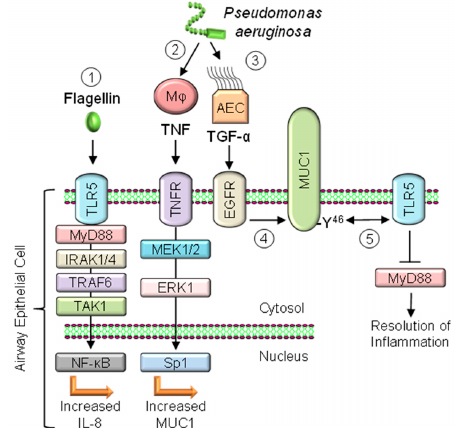
Figure 2. Hypothetical model for the proposed anti-inflammatory role of MUC1 in response to P. aeruginosa lung infection. (1) Flagellin engagement of TLR5 triggers a canonical MyD88 → IRAK1/4